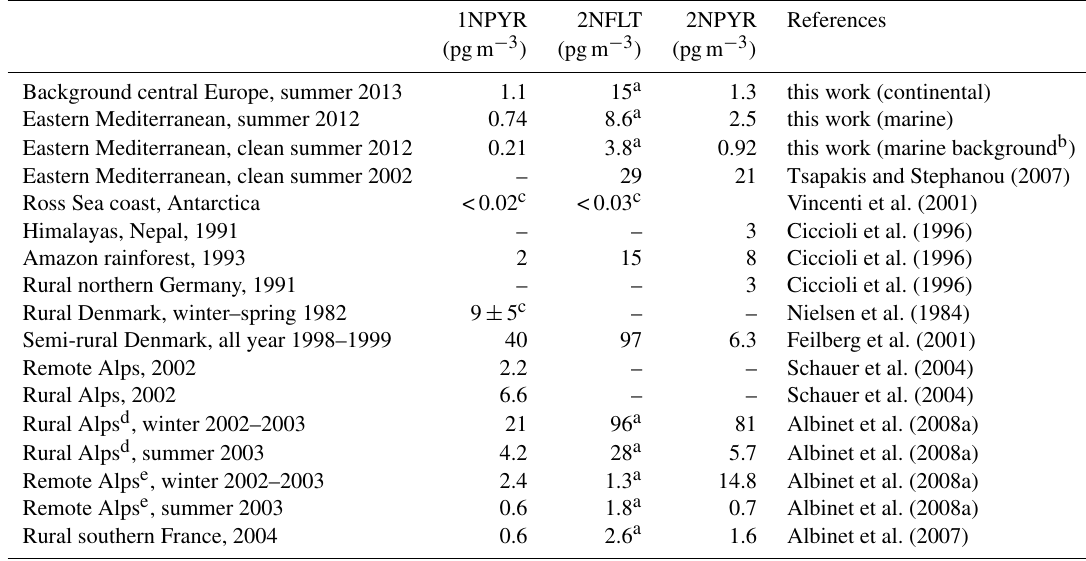
Table 3. Comparison of total (g + p) concentrations in air, c tot (pgm − 3 ) , with other measurements at remote and rural